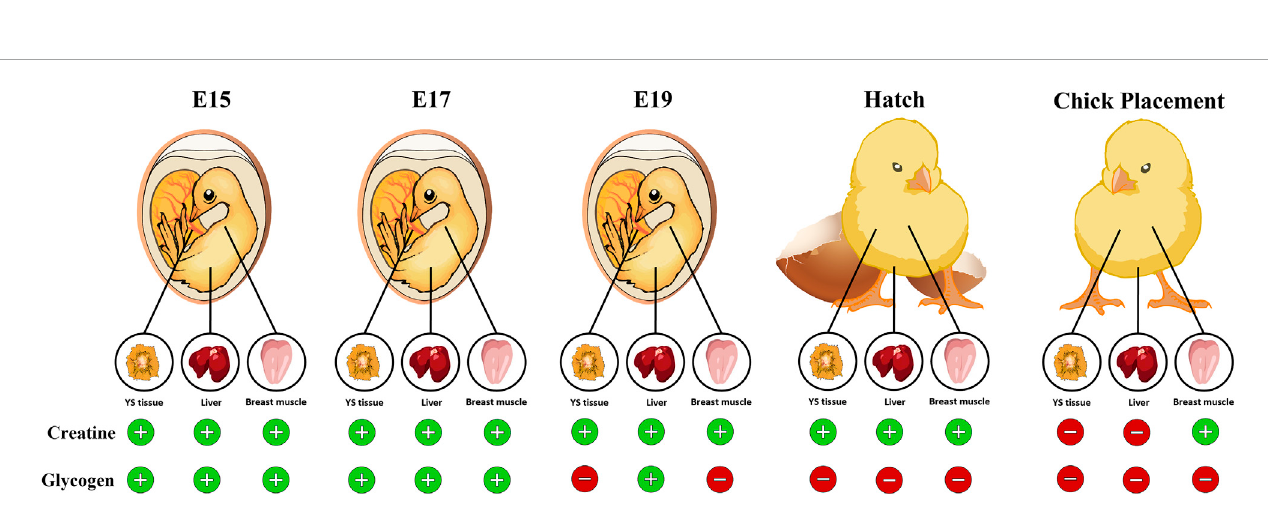
FIGURE 7 Graphical illustration demonstrating the available energy resources (creatine and glycogen) in the chicken embryo during the pre-post hatch period. Towardshatch,creatinelevelsintheYStissue,liverandbreastmuscleincreasewhileglycogenlevelsdramaticallydecrease,reachinglowlevelsathatchandat chick placement. In the breast muscle, as glycogen levels are depleted, creatine levels are elevated. Thus, highlighting the importance of creatine as an available energy source for the late-term embryo and